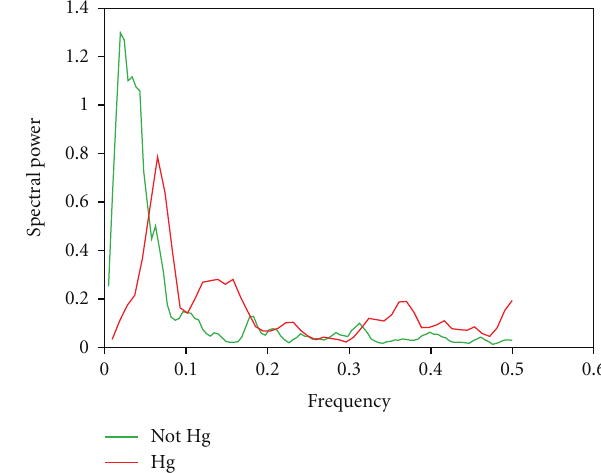
Figure 4: Pooled power spectra derived from hydrogen isotope ratios. There is statistically significant less low power ( P < 0 . 05) in the mercury (Hg) spectrum (red) derived from Huancavelica hair.